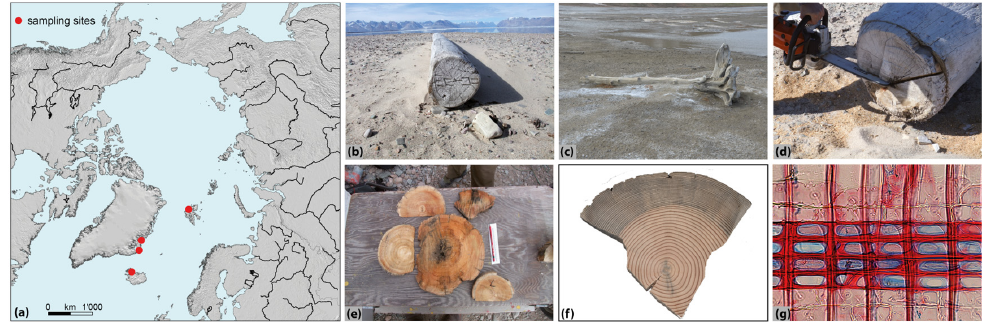
Figure 1. Driftwood sampling and wood identification: ( a ) Sub-Arctic and Arctic driftwood sampling sites ( b ) Logged driftwood timber in Greenland with a clear cut surface (credit: Willy Tegel); ( c ) Naturally fallen driftwood stem with a root collar; ( d ) Sampling of a driftwood disc (credit: Willy Tegel); ( e ) Variety of driftwood samples (credit: Willy Tegel); ( f ) Sanded Pinus sylvestris driftwood sample; ( g ) Stained radial cut of Pinus sylvestris for microscopic species identification. Table 1. Origin areas of logged cross-dated driftwood samples for pine, spruce and larch. Region